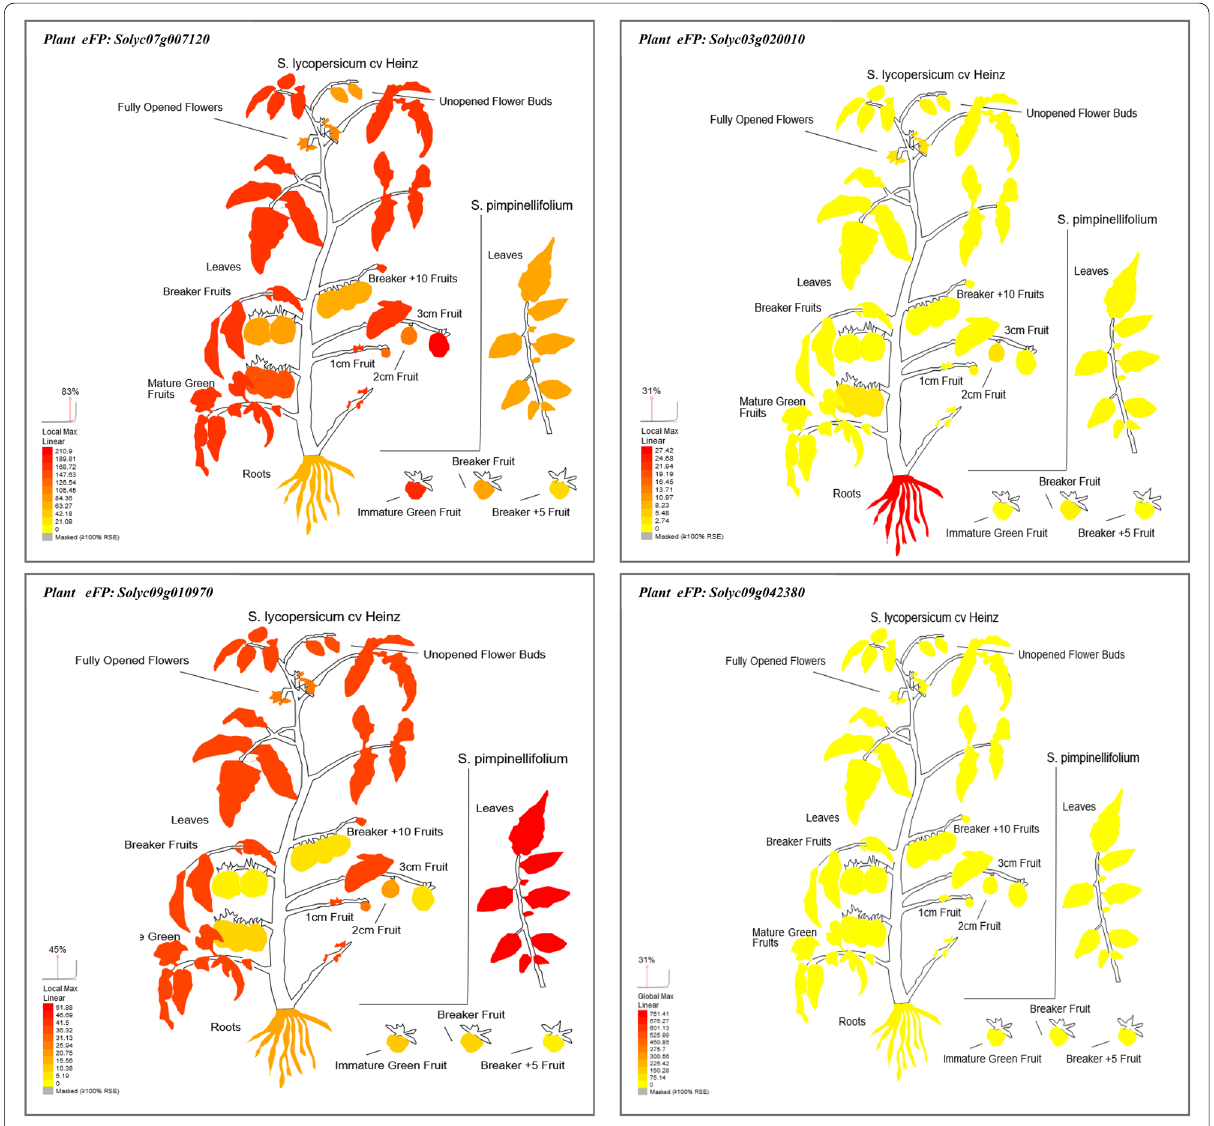
Fig. 5 Visualization of the putative a “plant electronic fluorescent pictograph” browsers for exploring the putative tissue expression of Solyc07g007120 , Solyc03g020010 , Solyc09g010970 , and Solyc09g042380 genes, based on tomato gene expression and protein localization at different tissues and developmental stages. The bar represents the expression scale (the more intense the red color, the more gene expression) http:// bar. utoro nto. ca/ eplant_